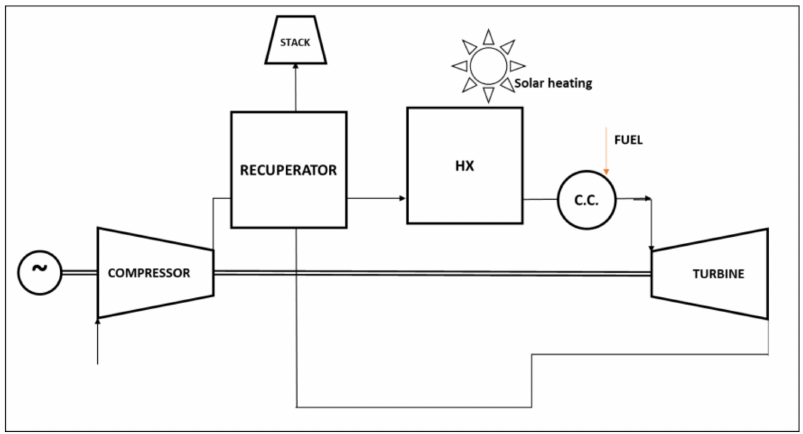
Figure 13. Solar-MGT scheme